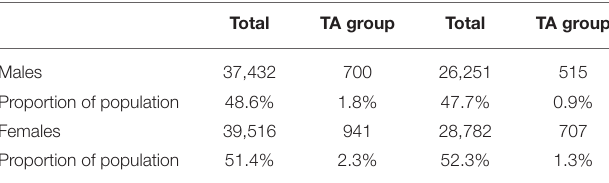
TABLE 2 | Number of female and male test-takers in total and representation in the group taking the time accommodated test for administration 16A (left column) and 16B (right